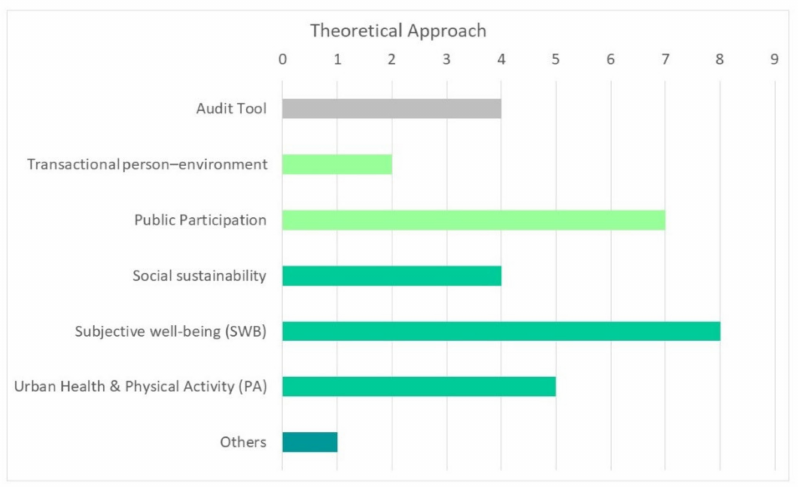
Figure 4. Theoretical approaches for the subjective assessment of the built